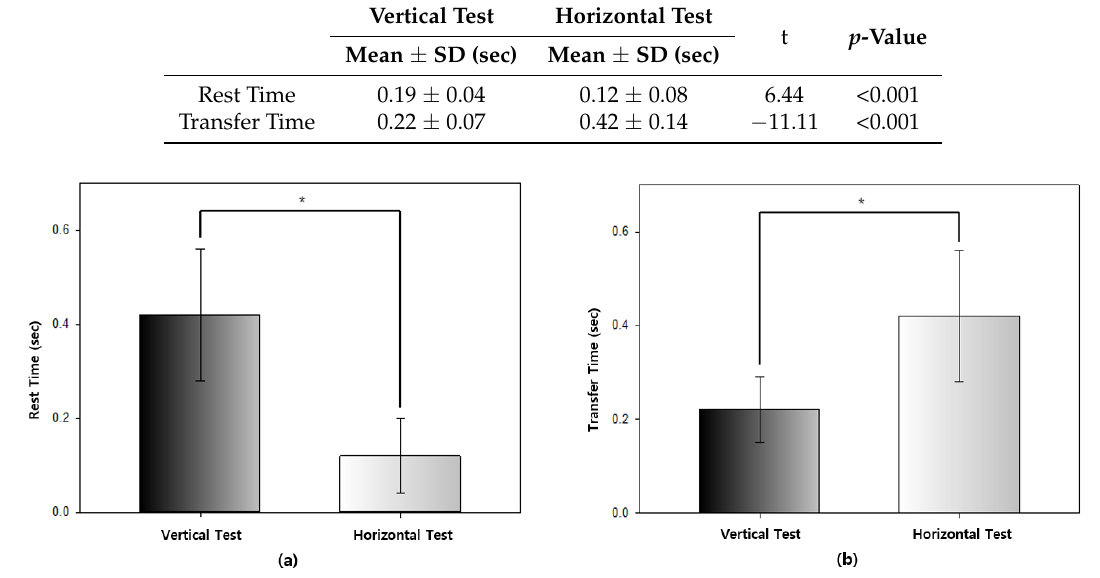
Table 8. A comparison of the rest time and transfer time.